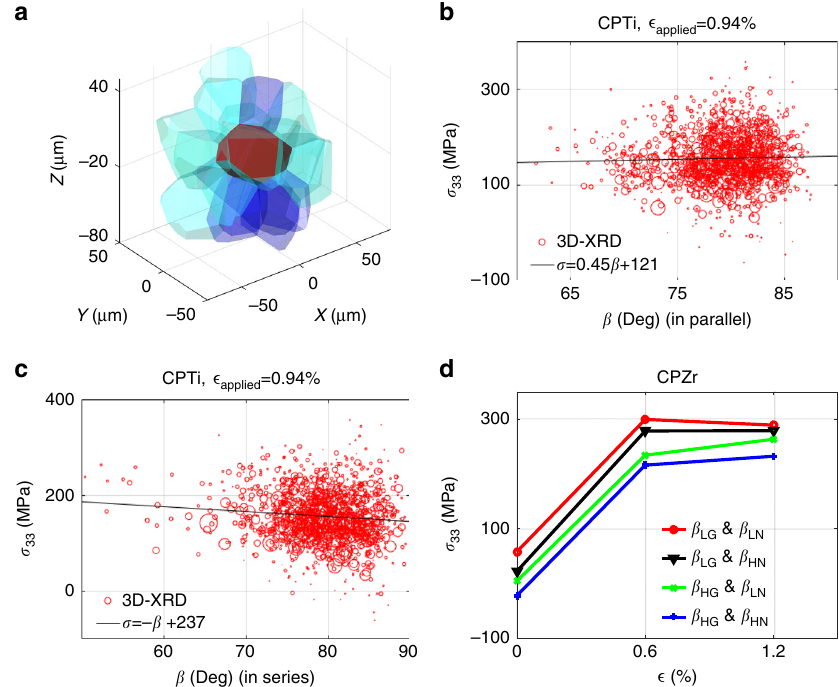
Fig. 6 Effects of grain neighbourhood. a An example of parallel and serial grains: dark and light blue represent grains adjacent in z -direction and x – y plane, respectively. σ 33 as a function of β averaged over neighbours for CPTi grains ( b ) in parallel and ( c ) in series. The size of each circle is proportional to the measured grain relative volume. d 3D-XRD results for load sharing between grains. β represents the angle between the loading direction and the crystal c - axis, subscripts HG, LG and 'N' represent low β , high β and neighbouring grain, respectively indicates the level of correlation. On the other hand, grains in series should show the opposite trend and this is indeed captured by 3D-XRD measurements (Fig. 6c). The effect is stronger here with the correlation line through the data have a gradient of − 1.0 MPa per °. To further evaluate the in fl uence of grain neighbourhood on local load sharing, grains were divided into four categories: grains with low β and neighbours in series with low average β ( β LG and β LN ), grains with low β but neighbours in series with high average β ( β LG and β HN ), grains with high β but neighbours in series with low average β ( β HG and β LN ), and grains with high β and neighbours in series with high average β ( β HG and β HN ). In Fig. 6d, the evolution of stress for the four categories measured by 3D-XRD on CPZr is shown. It is shown that hard grain in series with hard neighbours ( β LG and β LN ) has the most obvious stress drop among all while possess the highest σ 33 stress. For this case, hard grains are surrounded by hard neighbours and